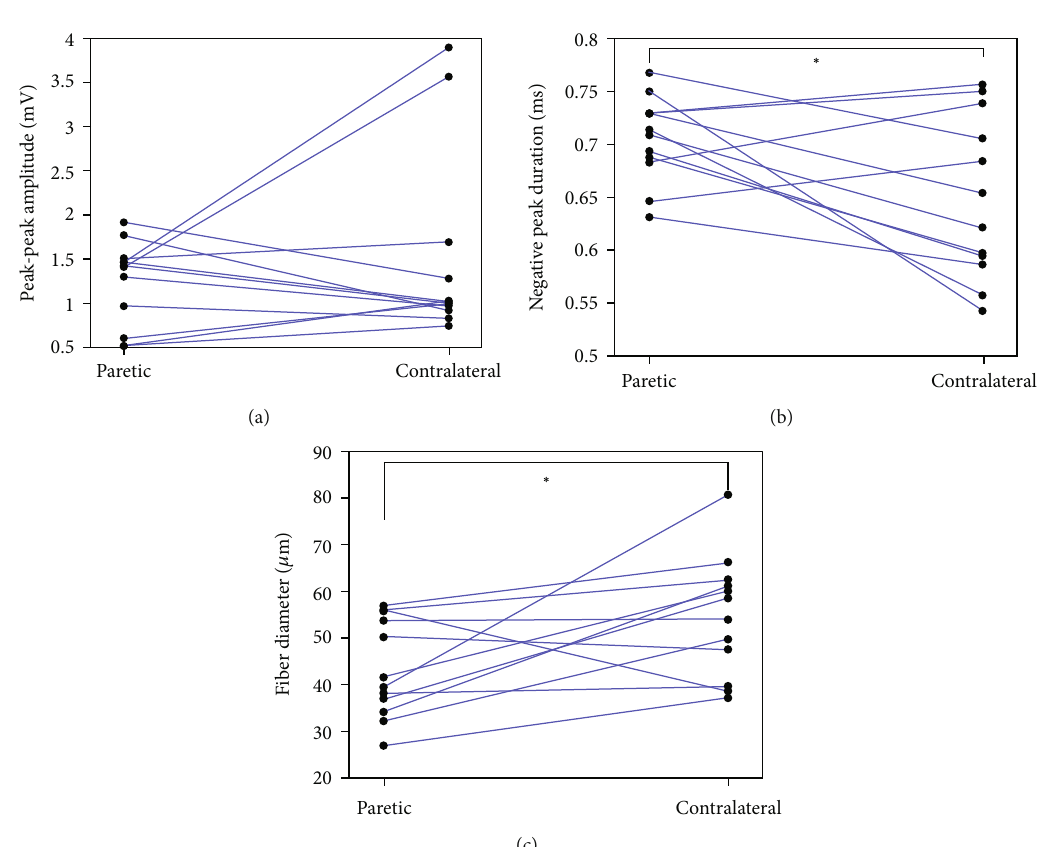
Figure 4: A comparison of (a) SFAP amplitude, (b) SFAP negative peak duration, and (c) estimated fi ber diameter between paretic and contralateral muscles of the tested stroke